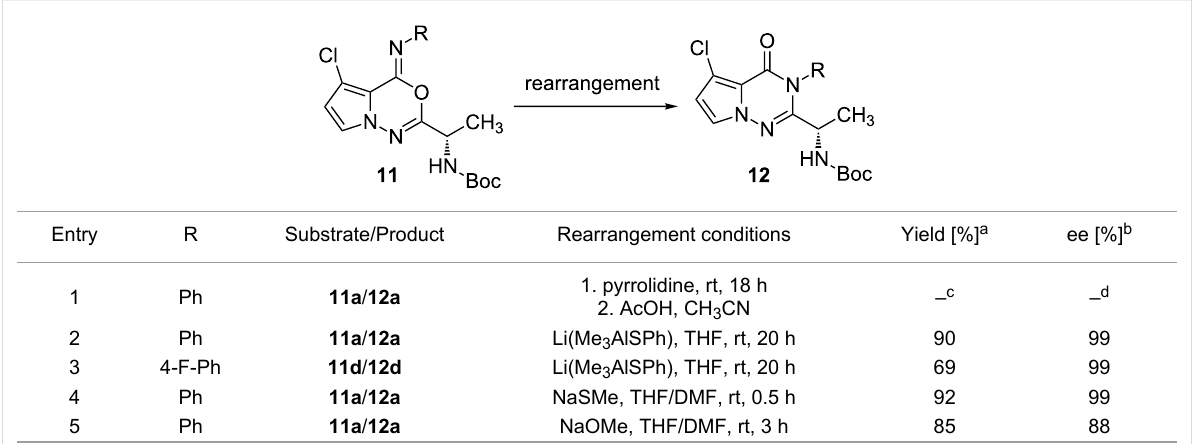
Table 2: Rearrangement of pyrrolooxadiazine 11 to pyrrolotriazinone 12 .